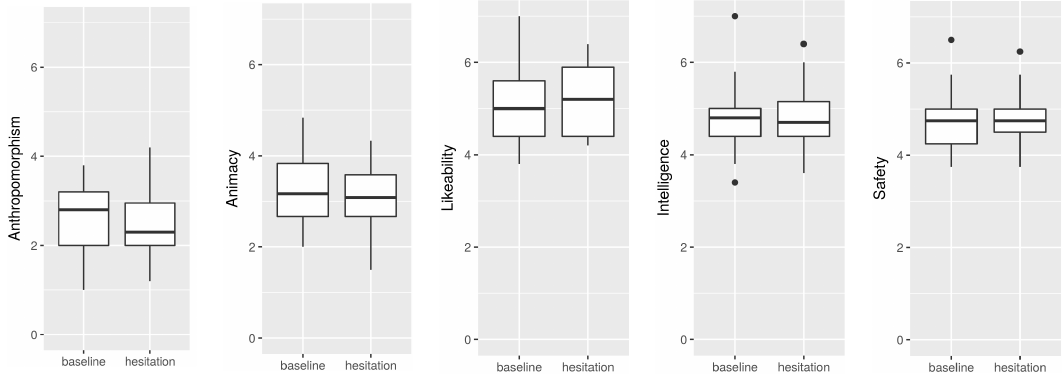
Figure 7. Subjective ratings for the five key